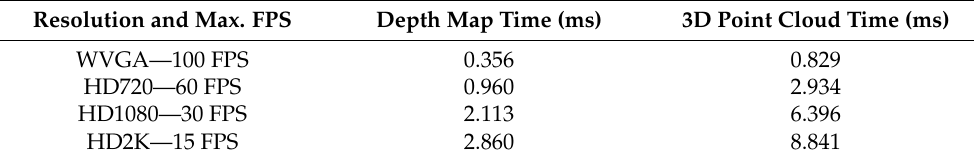
Table 2. The time needed to obtain the depth map and point cloud of a scene, calculated by averaging 50 consecutive depth and point cloud retrieval tests for 4 resolutions with their maximum possible frame